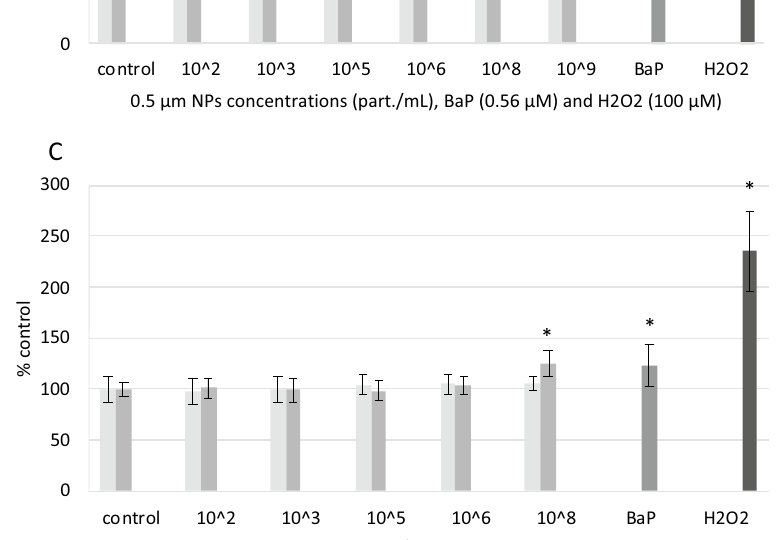
Figure 7. ROS production in mussel hemocytes exposed for 24 h to ( A ) 0.05 µm NPs, ( B ) 0.5 µm MPs and ( C ) 4.5 µm MPs alone or in combination with BaP, to BaP alone and to 100 µM H 2 O 2 (positive control). Data are given as percentages with respect to control ± SD (n = 18). * indicates significant differences with respect to controls, # indicates significant differences between NPs/MPs with or without BaP and $ indicates significant differences between NPs/MPs with BaP and BaP